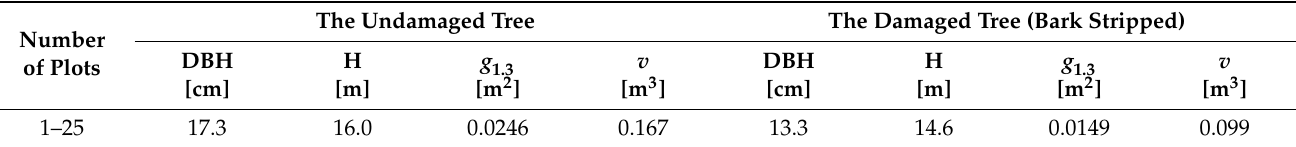
Table 2. Mean values of the biometric parameters for trees with or without bark damage.